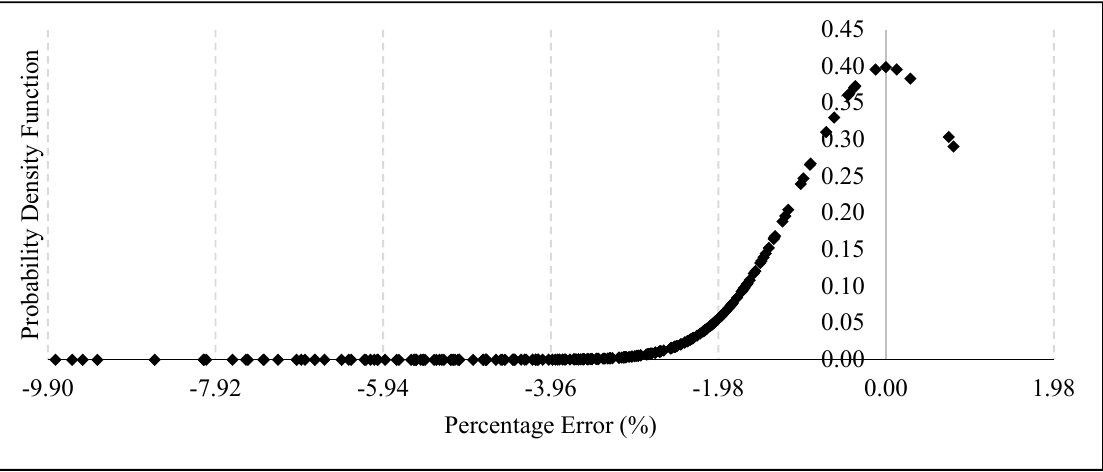
Figure 8. Probability distribution of the error obtained using the developed empirical equations based on FEA.